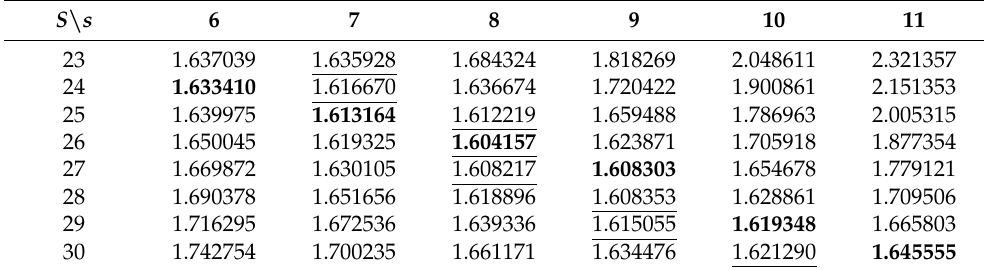
Table 1. Total expected cost S vs. s .